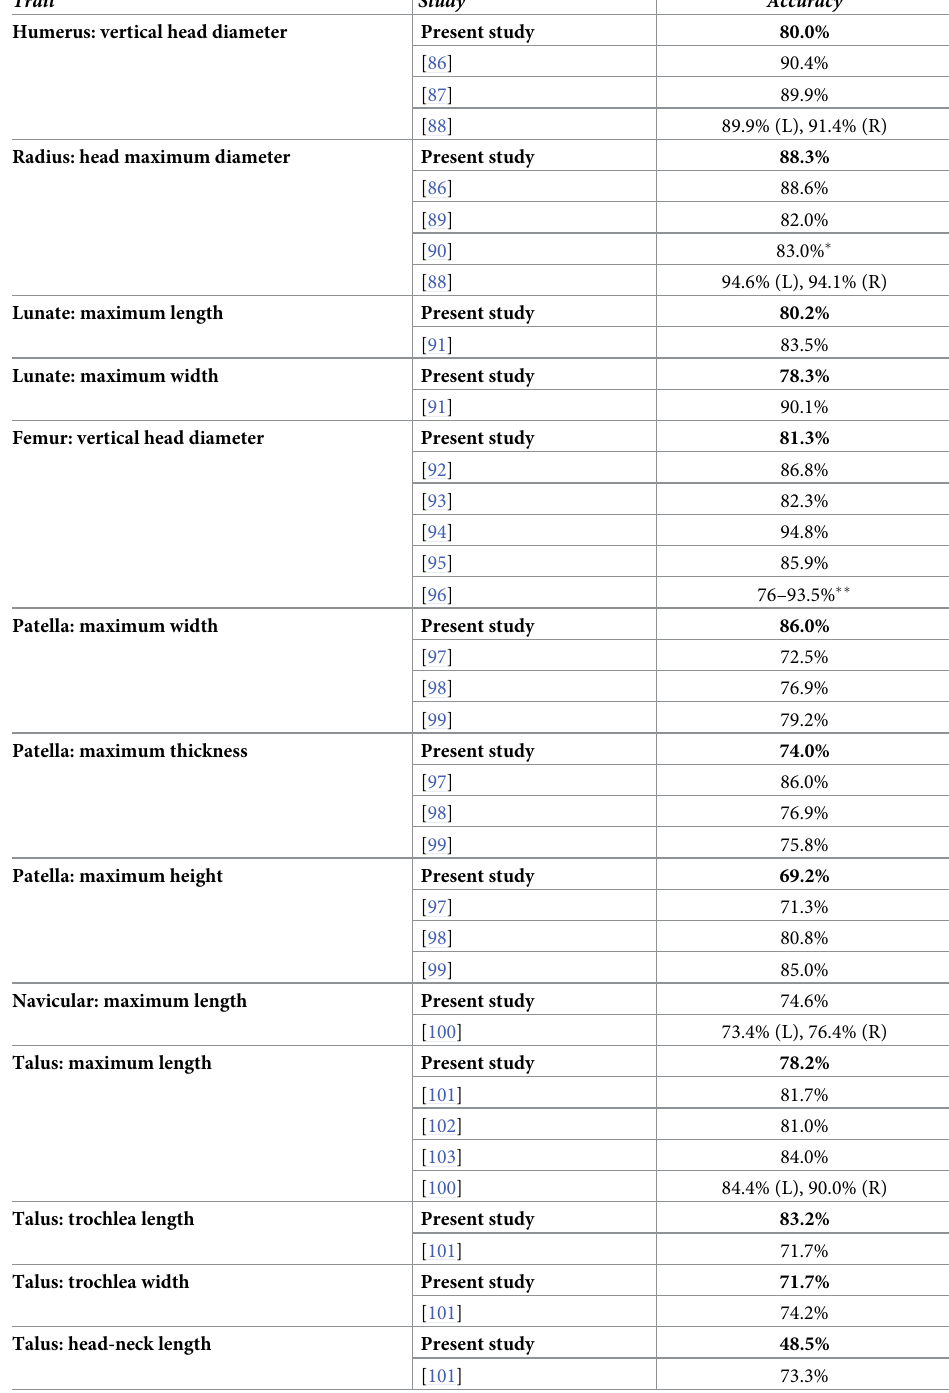
Table 5. Sex estimation accuracy levels registered in the present study and studies on unburned modern